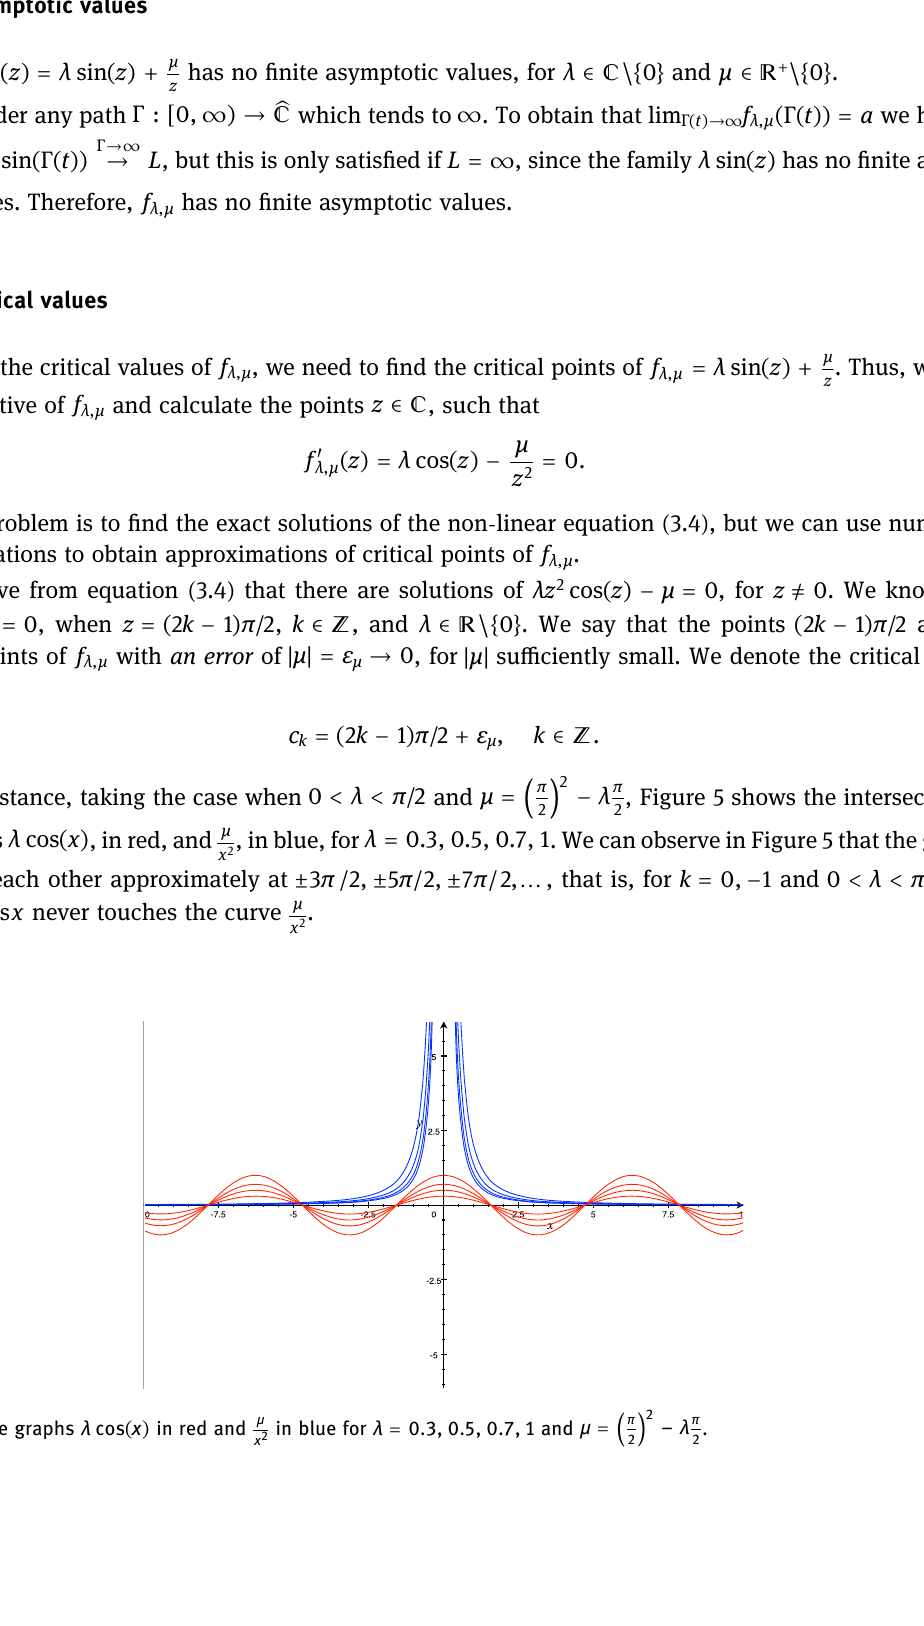
Figure 5: The graphs λ x cos ( ) in red and μ